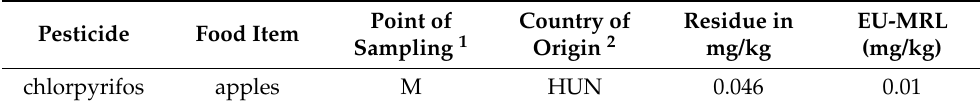
Table A11. Details of residues exceeding